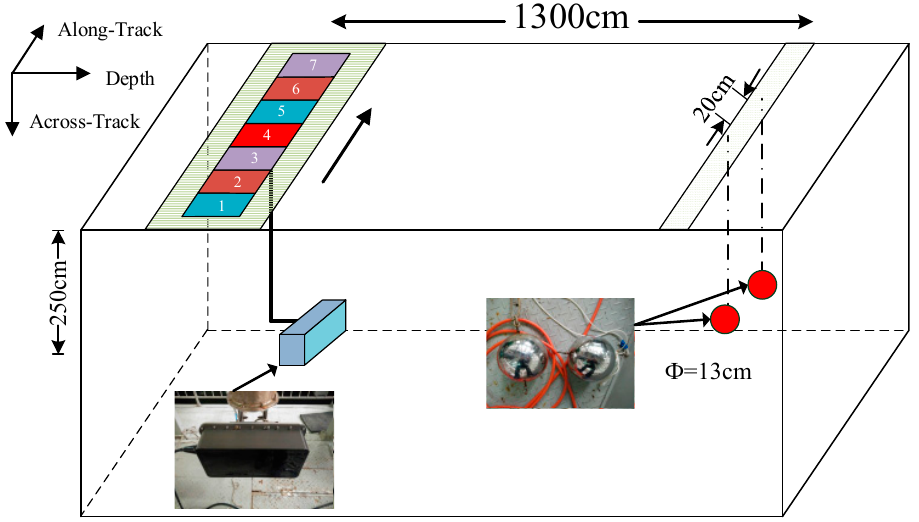
Figure 11. Dual balls target imaging experiment of MBSAS.